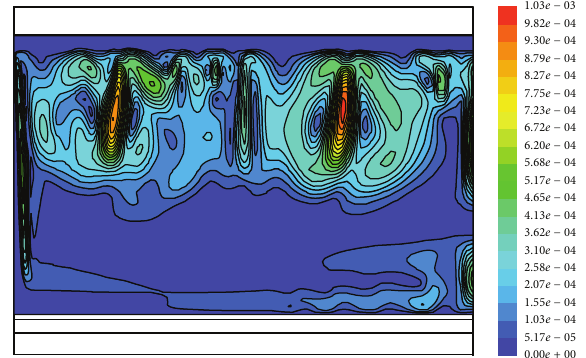
Figure 18: Contours of velocity